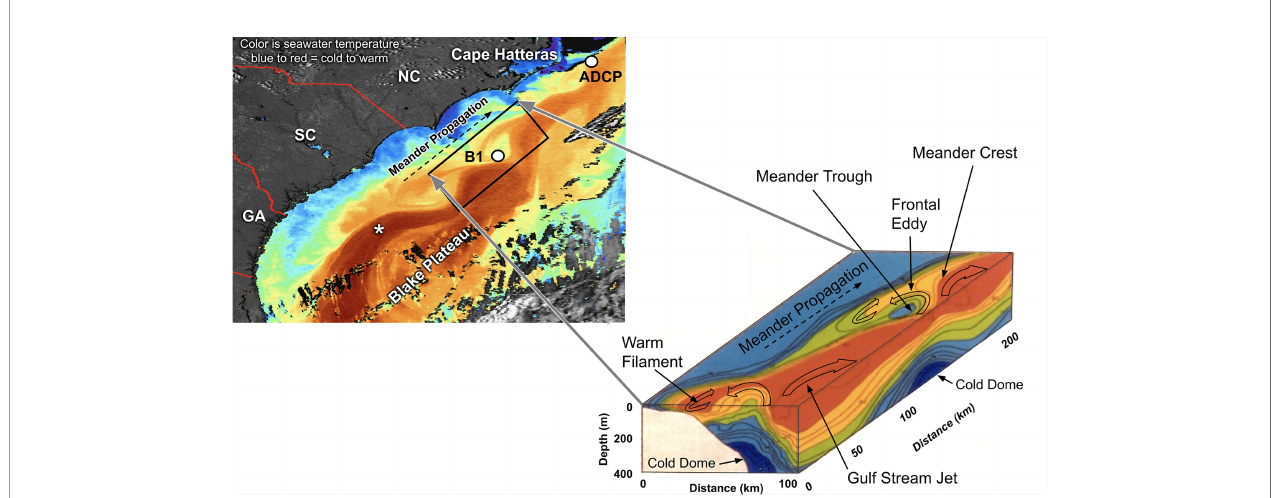
FIGURE 1 | Gulf Stream meander SST image (upper left) and associated 3-D volume view of meander features annotated (lower right). The location of mooring B1 (from Bane et al, 1981) is shown. Observed temperature and velocity time series from this mooring are shown schematically in Figure 2 . The white asterisk shows the center of the area known at The Charleston Bump. The Blake plateau is the relatively level bathymetric region beneath and offshore of the Gulf Stream, and extending from the lower frame of this image northward to just offshore of Cape